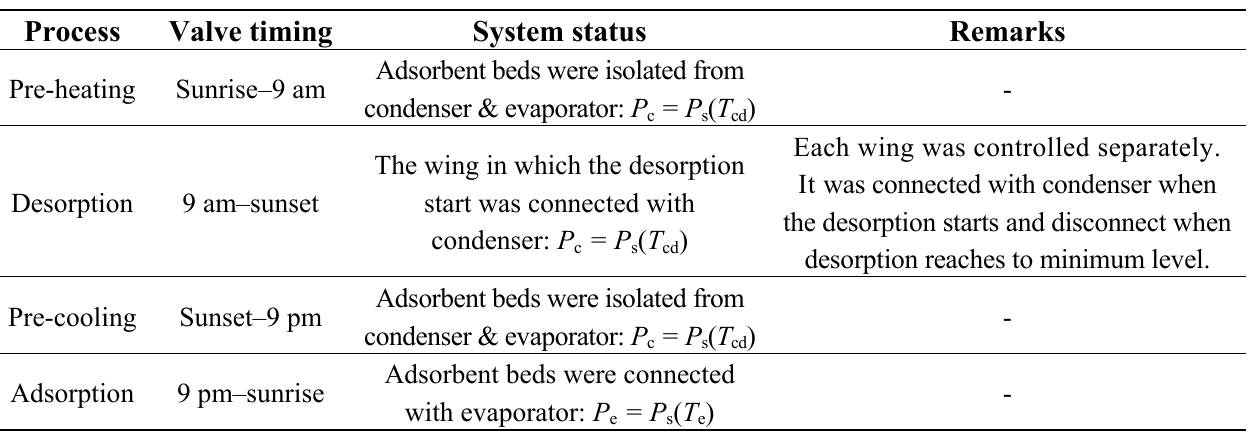
Table 2. Average valve operation timing and